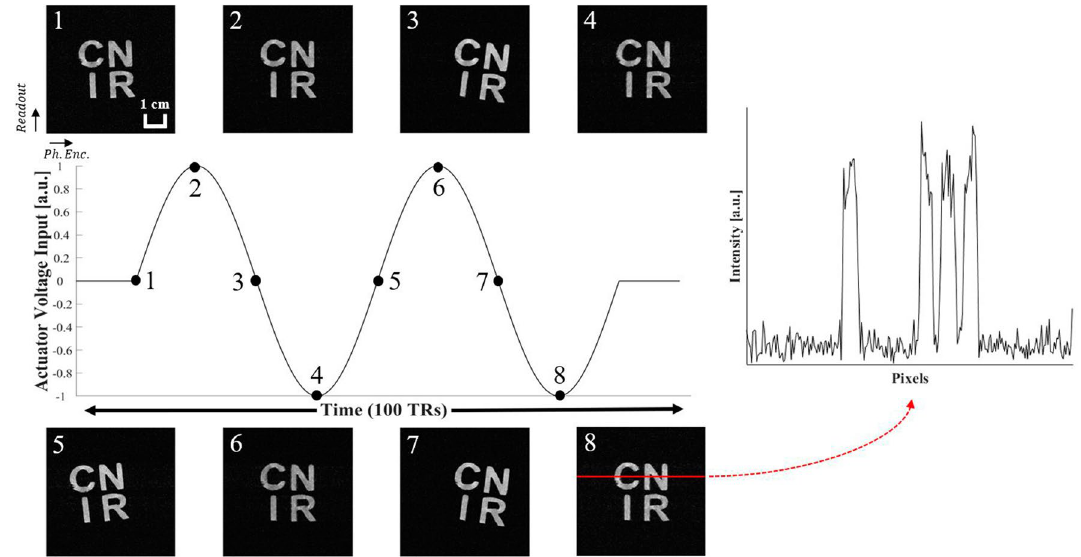
Figure 4. Scanning the letter-shaped agarose phantom with line-scan sequence. Two periods of sinusoidal waveforms in between a pair of brief zero intervals constituted one cycle of the actuator’s driving voltage. This was repeatedly applied to the actuator 256 ( = N phase ) times to produce the above images. The numbering on top left corner of each image indicates corresponding time points in the voltage input diagram with 10 TR-increments (800 ms). An example of linear intensity profile (red horizontal line) of Image 8 shows signal from the agarose gel clearly distinguishable from the background noise during the phantom’s movement.